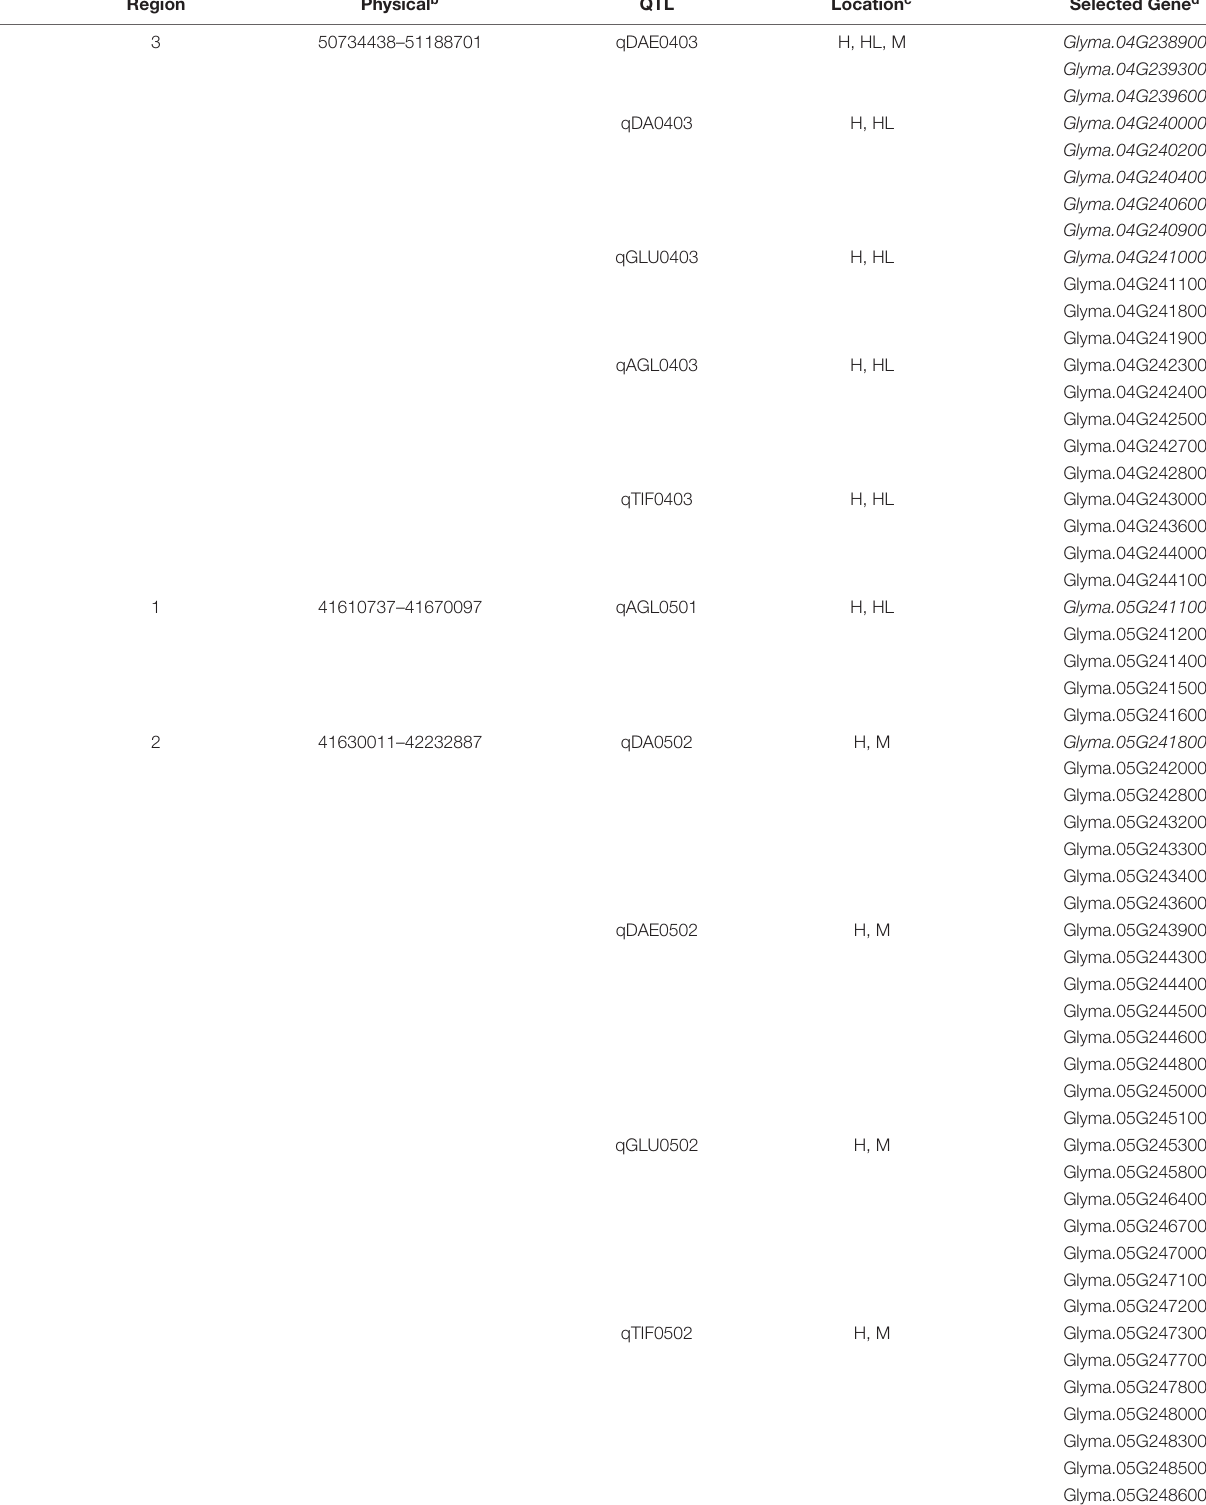
TABLE 7 | The selected genes of stable and sub-stable QTL. LG a Region Physical b QTL Location c Selected Gene